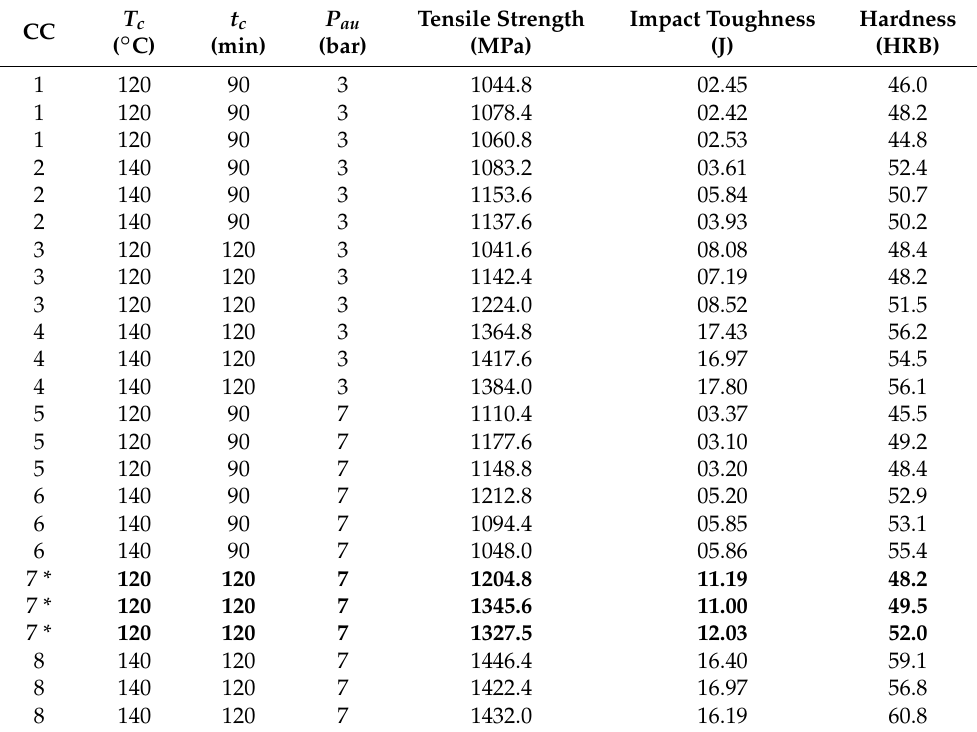
Figure 4. ( a ) Irop Parma autoclave used for polymerization/curing of CFRP laminates; ( b ) close-up of vacuum-bagged laminates after curing. Table 2. 2 3 full factorial design and mechanical tests results. MRCC parameters and corresponding properties are represented by bold numbers.